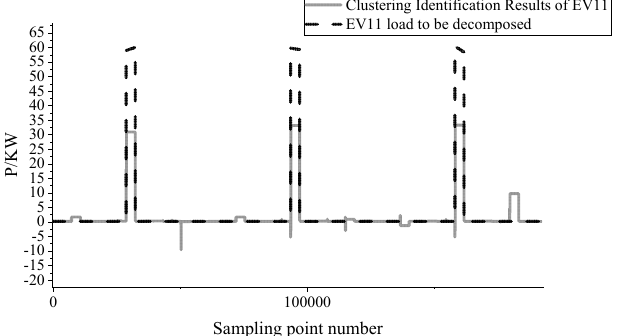
Figure 15. Decomposition results of new random load electric vehicle charging station EV11 by deep neural network.